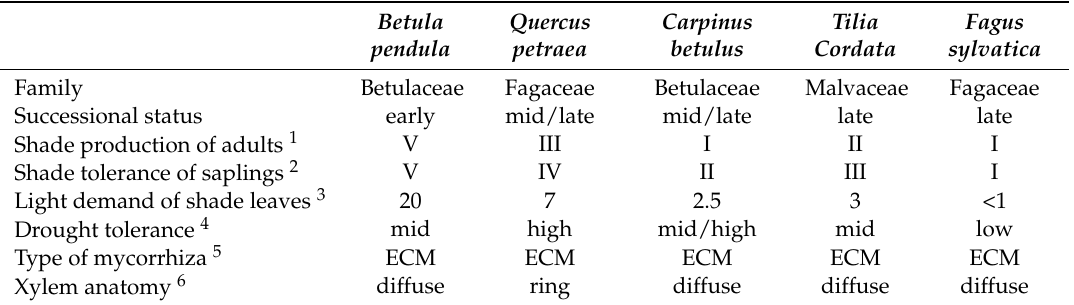
Table 1. Functional and morphological traits of the five studied tree species according to [23–28] and others.